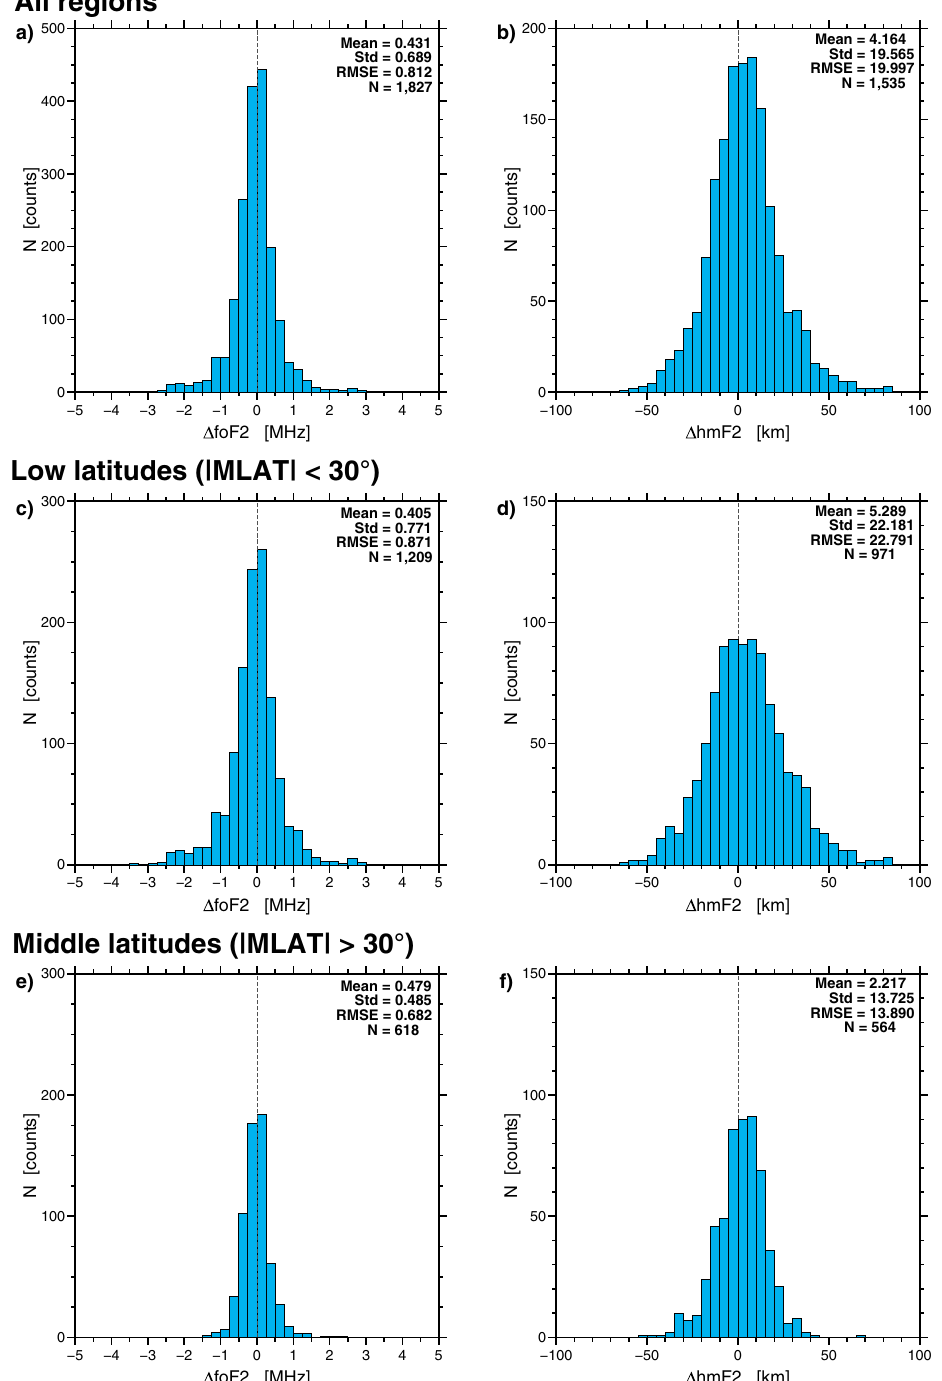
Fig. 5. Histograms of the F2 peak parameters residuals D foF2 ( D foF2 = foF2 RO – foF2 ionosonde ) and D hmF2 ( D hmF2 = hmF2 RO – hmF2 ionosonde ) between collocated COSMIC-2 and ionosonde measurements for (a – b) all regions and (c – f) with a division into low and middle latitudes. Each plot contains information about the mean, standard deviation, RMS error, and total number of